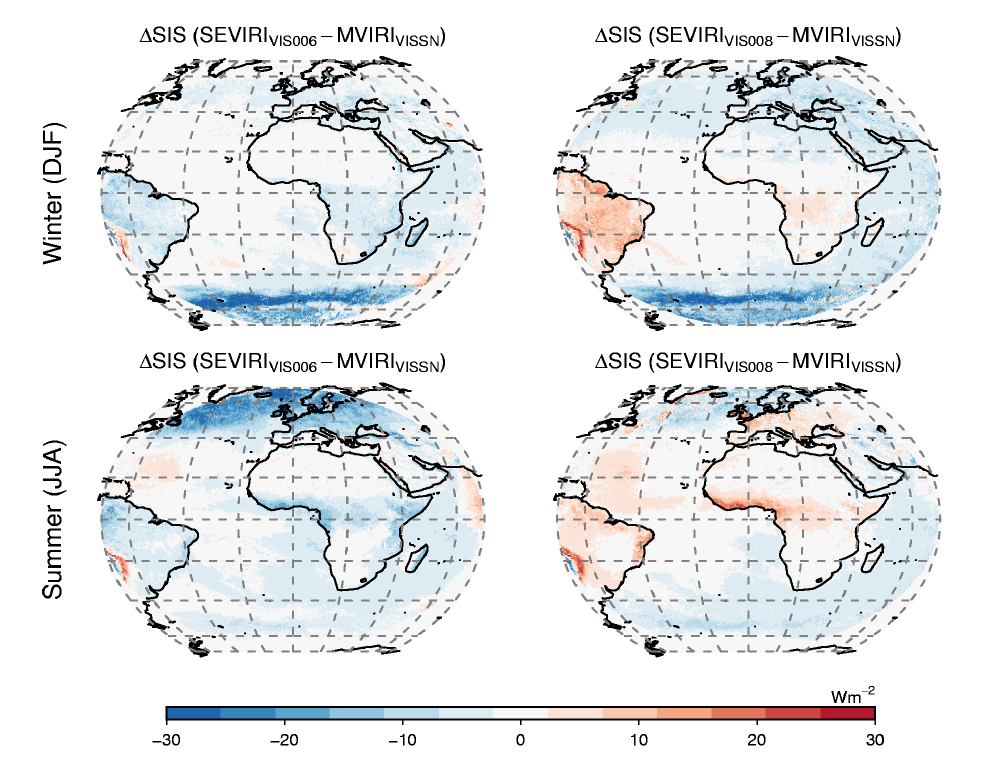
Figure 7. Seasonal differences (DJF: top row, JJA: bottom row.) between Meteosat-7 (MVIRI) and Meteosat-8 (SEVIRI) visible channels (VIS006: left column, VIS008: right